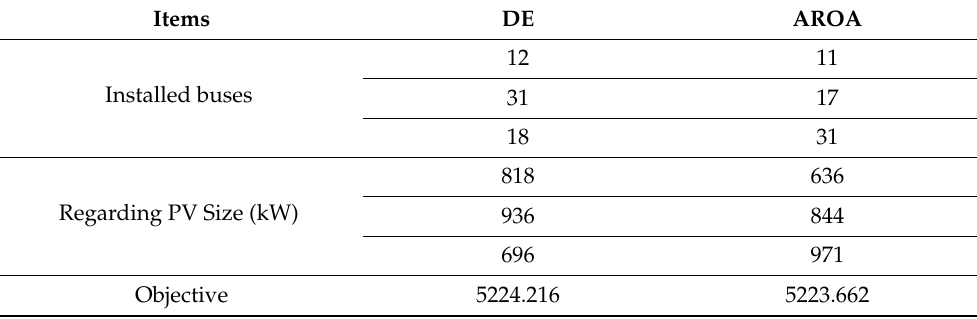
Table 1. Allocations of PV without STATCOM for the second scenario for the IEEE 33-distribution system.